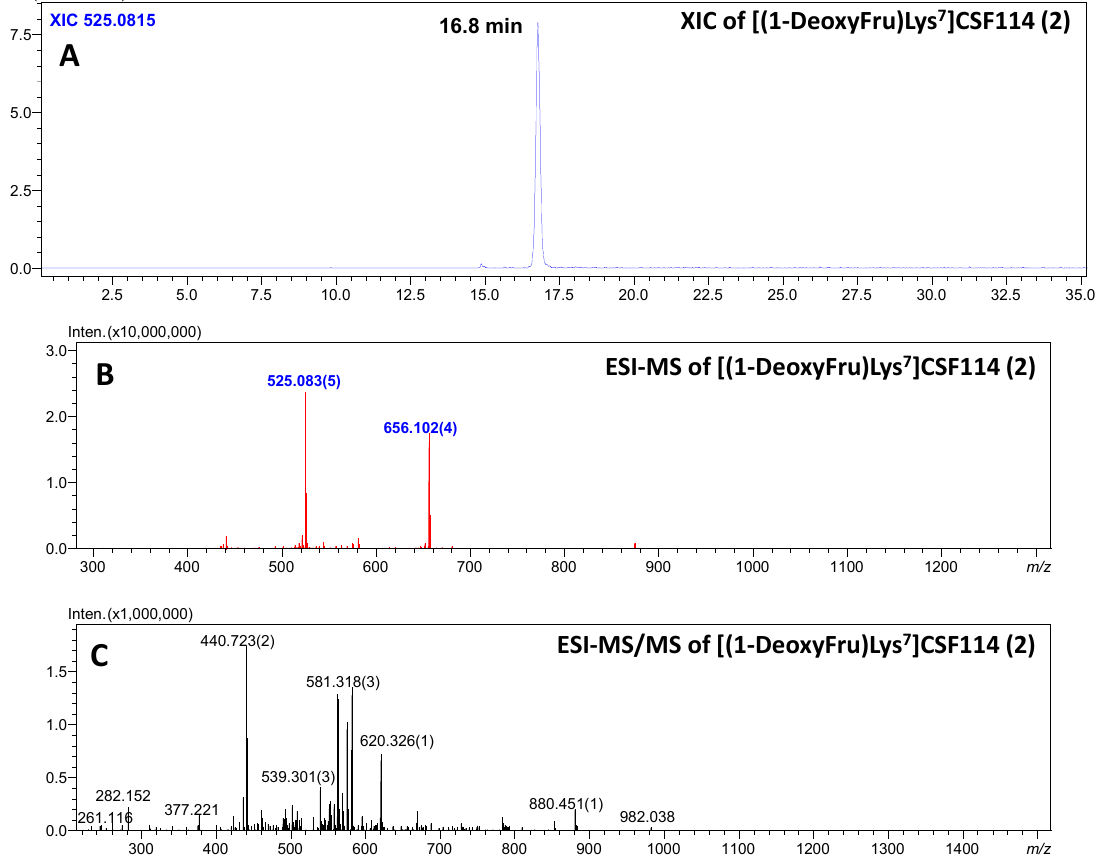
Figure 1. Analytical characterisation after performing the capturing procedure of the hydrolysate of Human Serum Albumin (HSA) with 2% w/w [(1-DeoxyFru)Lys7]CSF114 ( 2 ). Panel ( A ): Total Ion Chromatogram. Panel ( B ): ESI-MS. Panel ( C ): ESI-MS/MS.